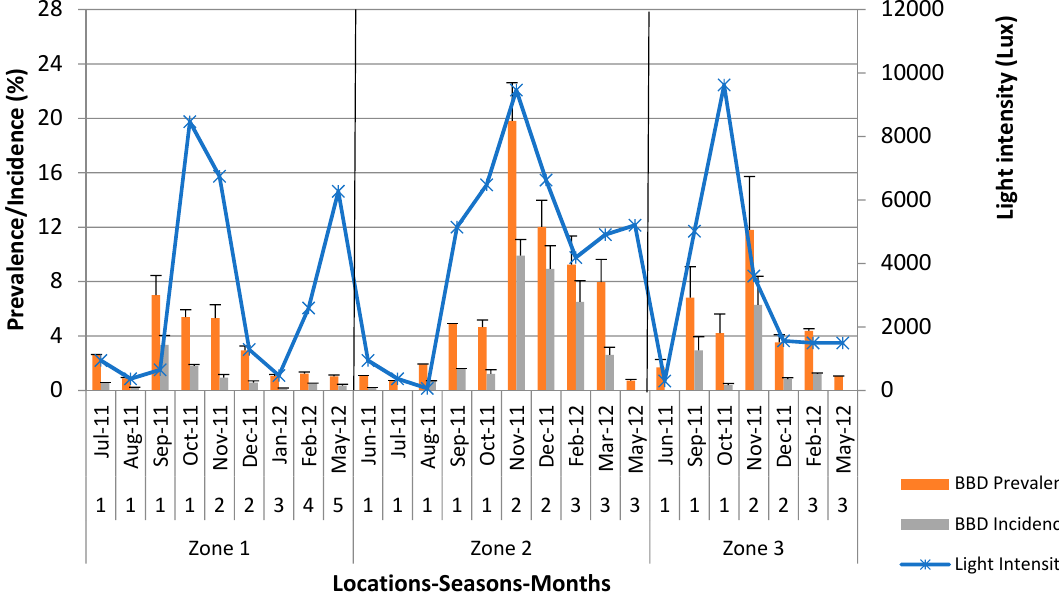
Figure 3. Coral disease prevalence and incidence on each season (dry season = 1; transition period = 2; and the rainy season = 3). Light intensity is displayed as a blue line. Zone are separated with a vertical lines.